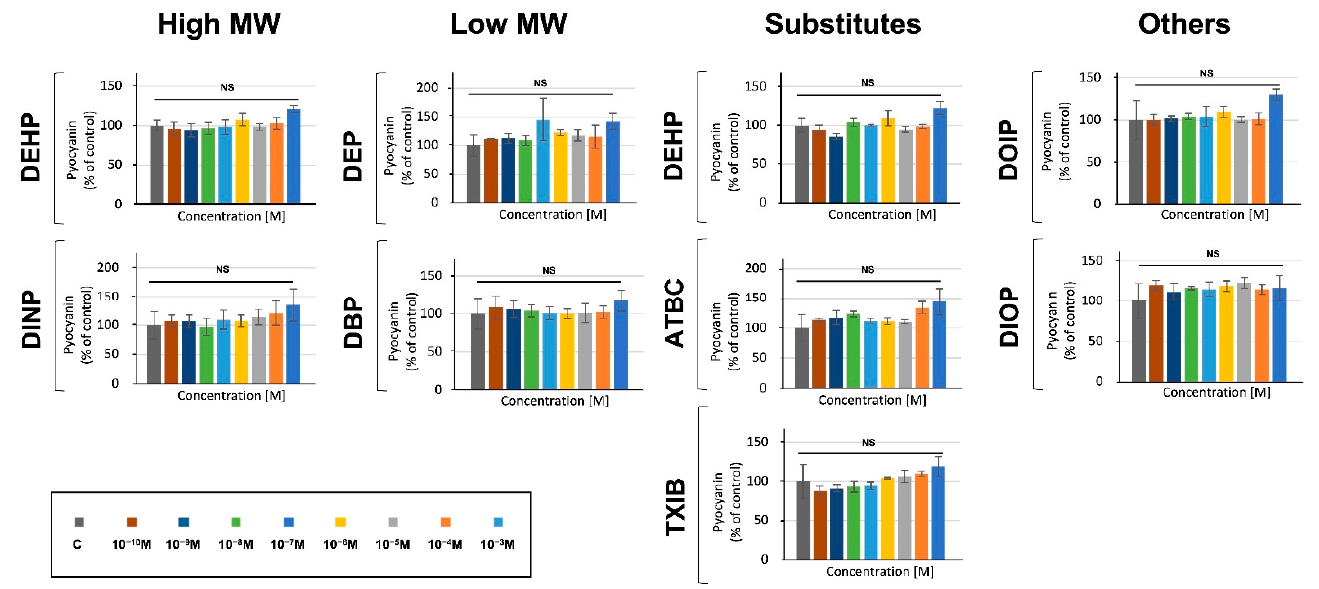
Figure 3. Phthalates or substitutes did not alter pyocyanin production . Phthalate and substitute concentrations ranging from 10 − 3 to 10 − 10 M (colors indicated in the scale). GC: P. aeruginosa ’s growth control in M9 succinate medium without phthalates or substitutes. NS = p > 0.05.